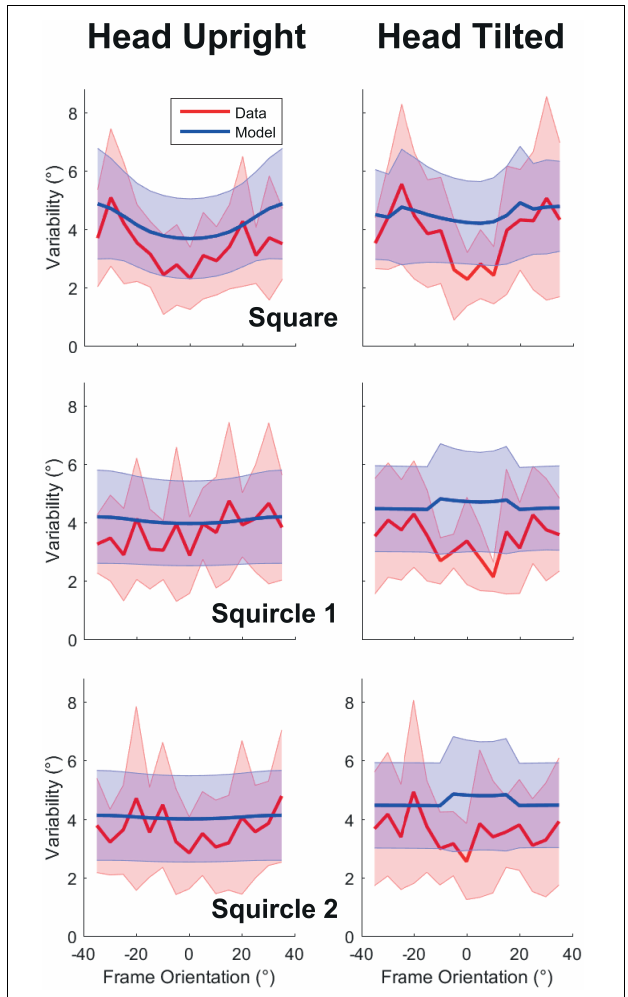
FIGURE 4 | Response variability as a function of frame orientation. Panels on the left correspond to the head upright condition, to the right to the head tilted condition. The panels from top to bottom correspond to the used frame forms: square, squircle 1, and squircle 2. Grand averages are plotted as lines, standard deviation across participants as shaded regions. In red are the observations, in blue, the results of the best-fit